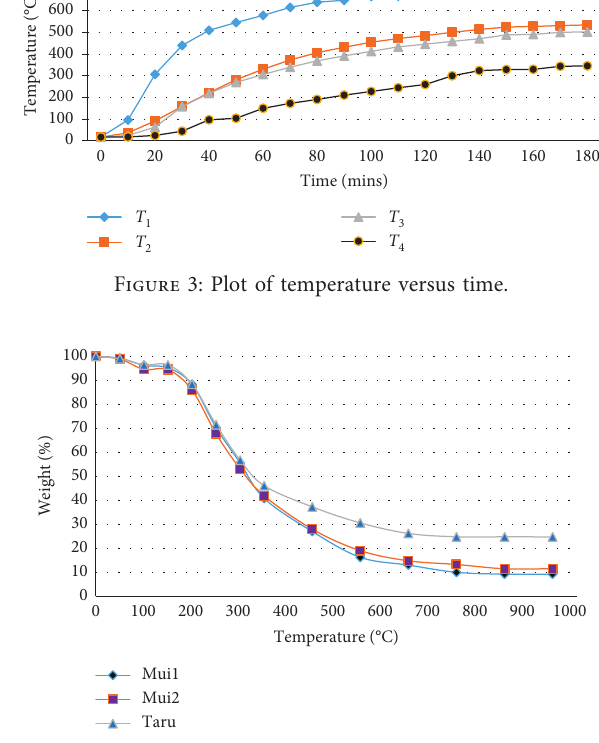
Figure 4: Plot of temperature–weight analysis Mui1, Mui2, and Taru coal.